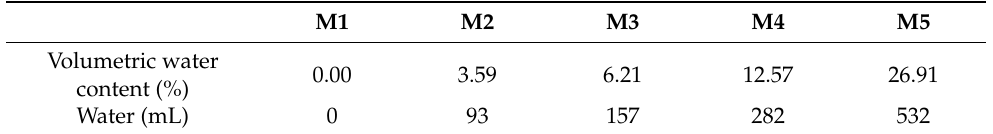
Table 3. Characteristics of the pots, first test.